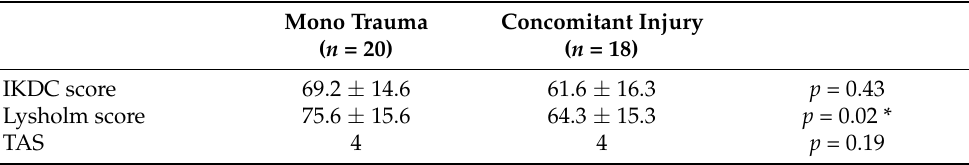
Table 4. Clinical outcome after knee luxation depending on concomitant injuries, such as lesion to nerves or vessels or multiple traumata. Between the 2 groups there was a significant difference (* indicates significant results; p < 0.05) regarding the Lysholm score. IKDC and Lysholm scores, presented by MD ± SD, and the TAS is presented by